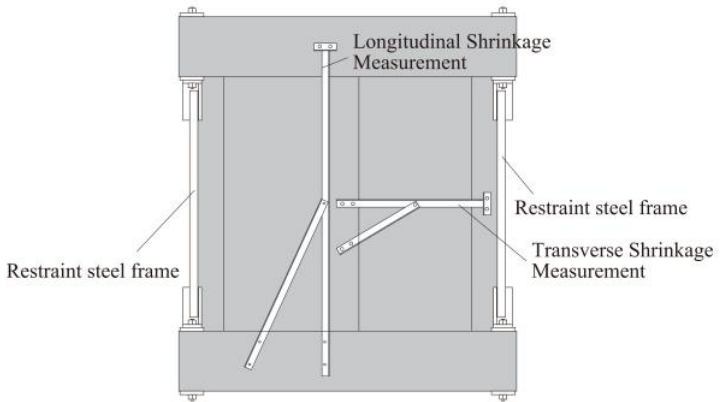
Figure 5. The measurement of the shrinkage